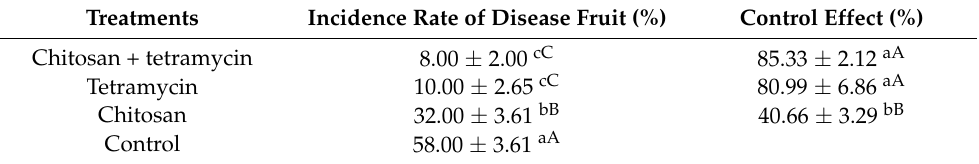
Table 2. The control effects of tetramycin and chitosan on soft rot diseases of kiwifruit. Treatments